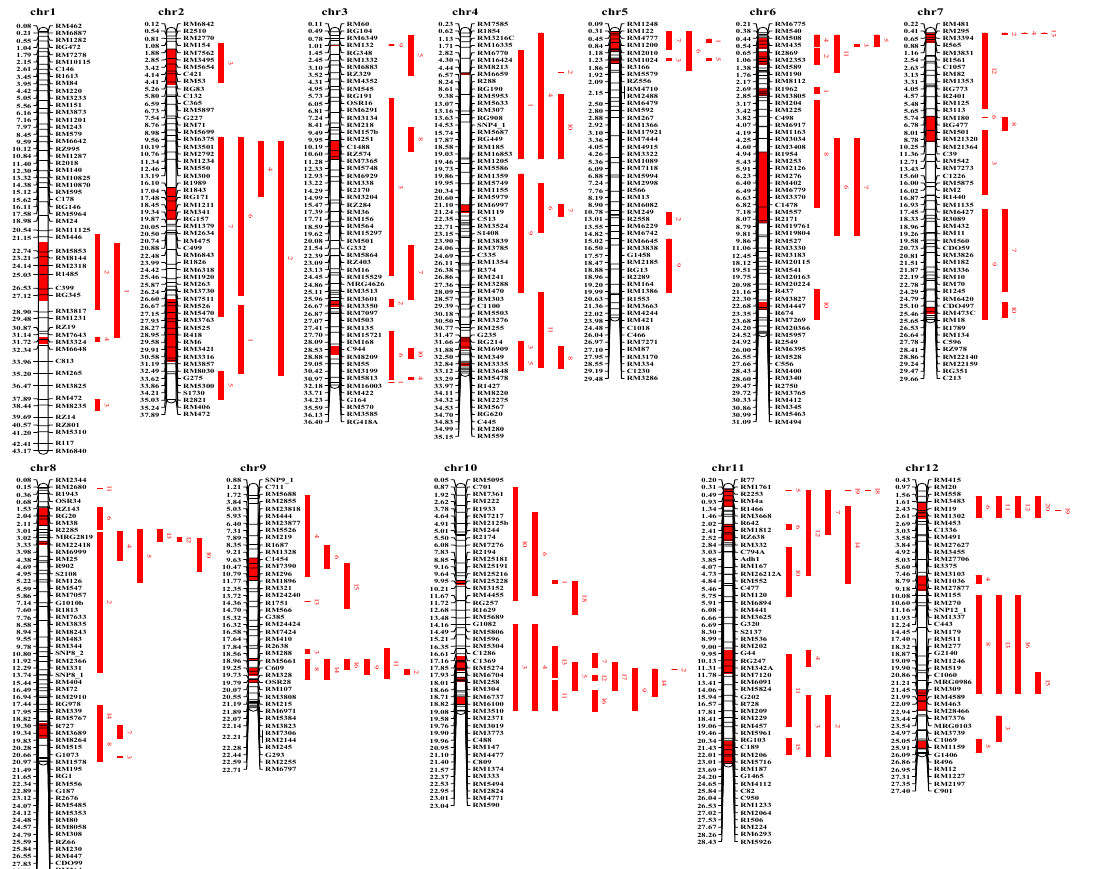
Figure 2. “Consensus” QTL map related to heat tolerance in rice. Chr: chromosome; The bars represent the chromosomes; The molecular markers are located on the right of chromosomes, the physical distances of those in mega base (Mb) are located on the left of chromosomes; The original QTLs are positioned on the right of molecular markers in the “consensus” map; Fragments with red color represent confidence intervals of meta-QTLs in the chromosomes. Table 2. 40 heat-tolerant meta-QTLs in rice.